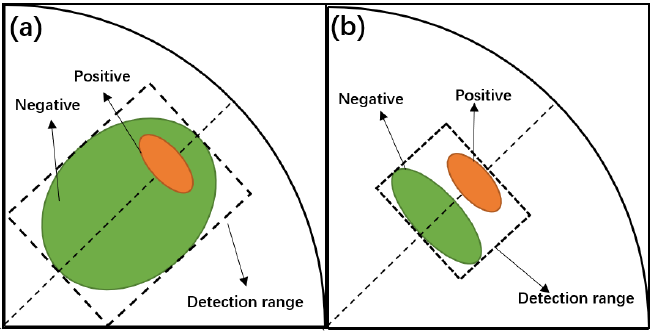
Figure 6. Range of radial velocity extreme value retrieval. ( a ) Retrieval range of radial velocity extreme value of large and small circles; ( b ) Retrieval range of radial velocity extreme value of two adjacent circles.